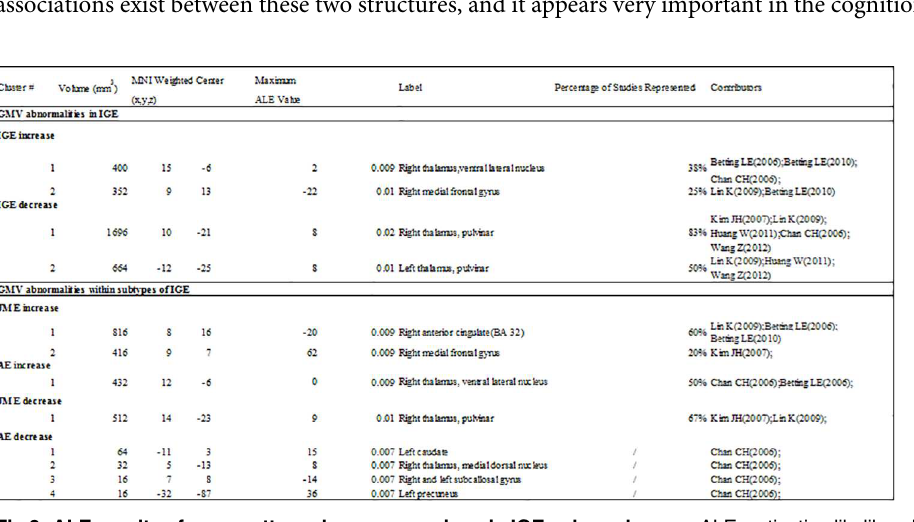
Fig 3. ALE results of gray matter volume comparison in IGE subsyndromes. ALE, activationlikelihood estimation;IGE, idiopathicgeneralizedepilepsy;JME, juvenilemyoclonic epilepsy;AE, absenceepilepsy; MNI, montreal